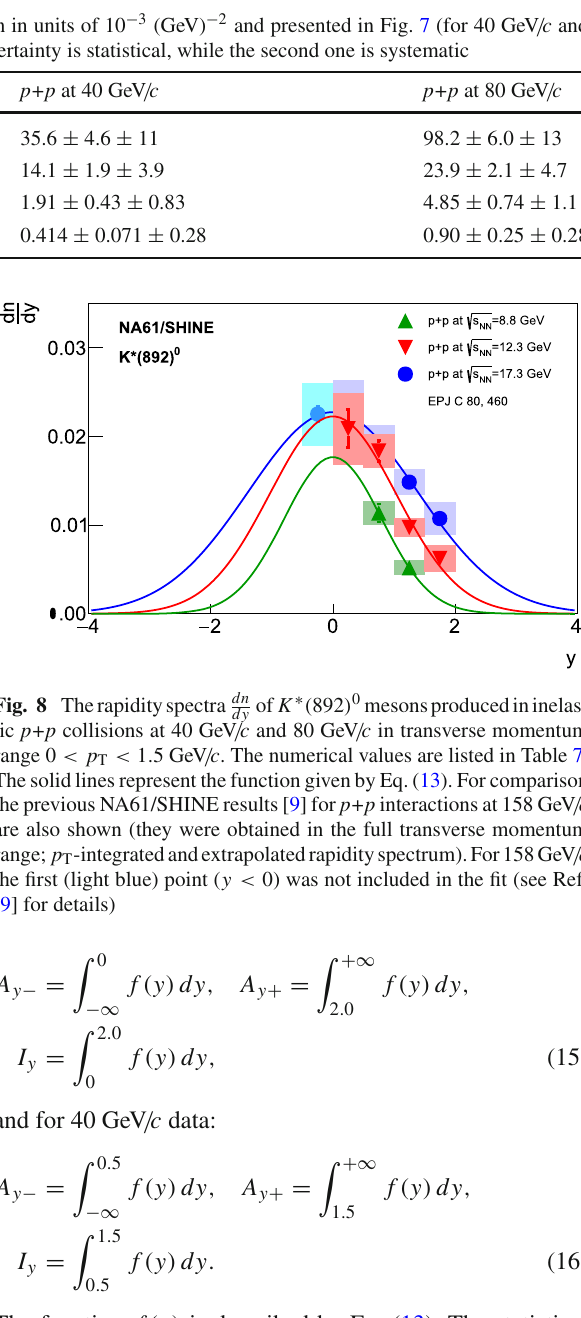
presented in Fig. 6, given in units of 10 − 3 (GeV / c ) − 1 . The first uncertainty is dydp T